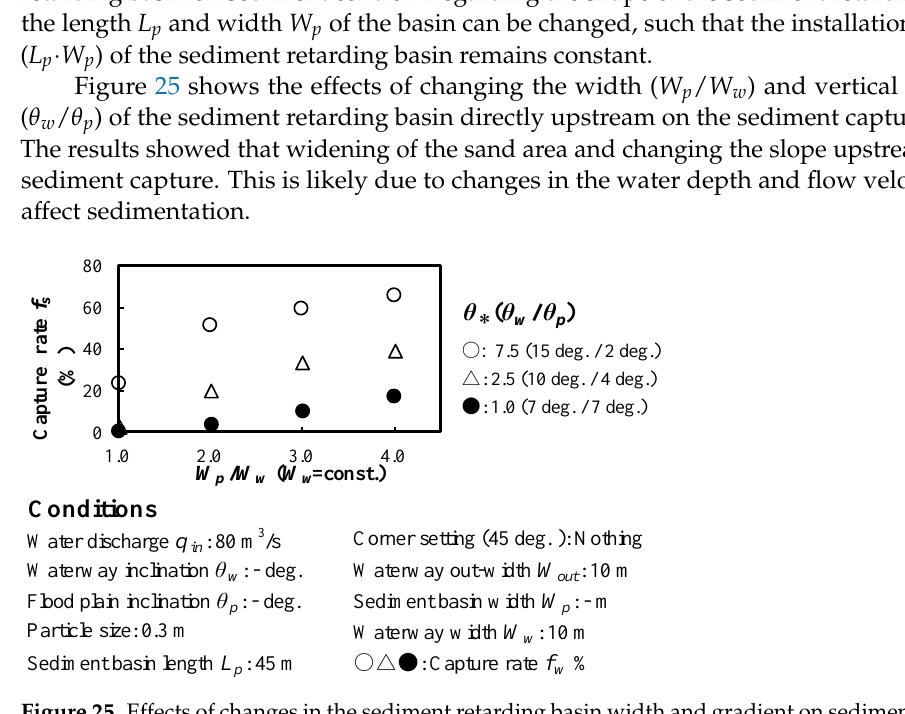
Figure 27. Effects of changes in the planar shape of the sediment retarding basin and the supply flow rate on sediment capture. Figure 28 shows the effects of the planar shape ( L p / W p ) of the sediment retarding ba- sin and the gradient change ( θ w / θ p ) immediately upstream of the sediment retarding basin on sediment capture f s . The change in the gradient showed a different tendency in the relationship between the shape of the sediment retarding basin and the sediment capture. Conditions Water discharge q in : - ㎥ /s